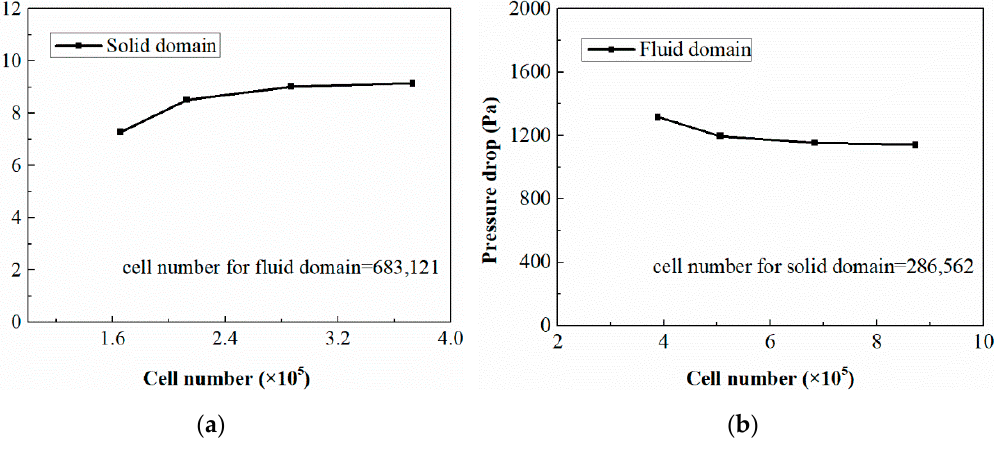
Figure 7. Mesh independency analysis: ( a ) vertical deformation of the impact point along -z direction at 0.01 s; ( b ) pressure drop between the entrance and exit of the pipe at 0.01 s.